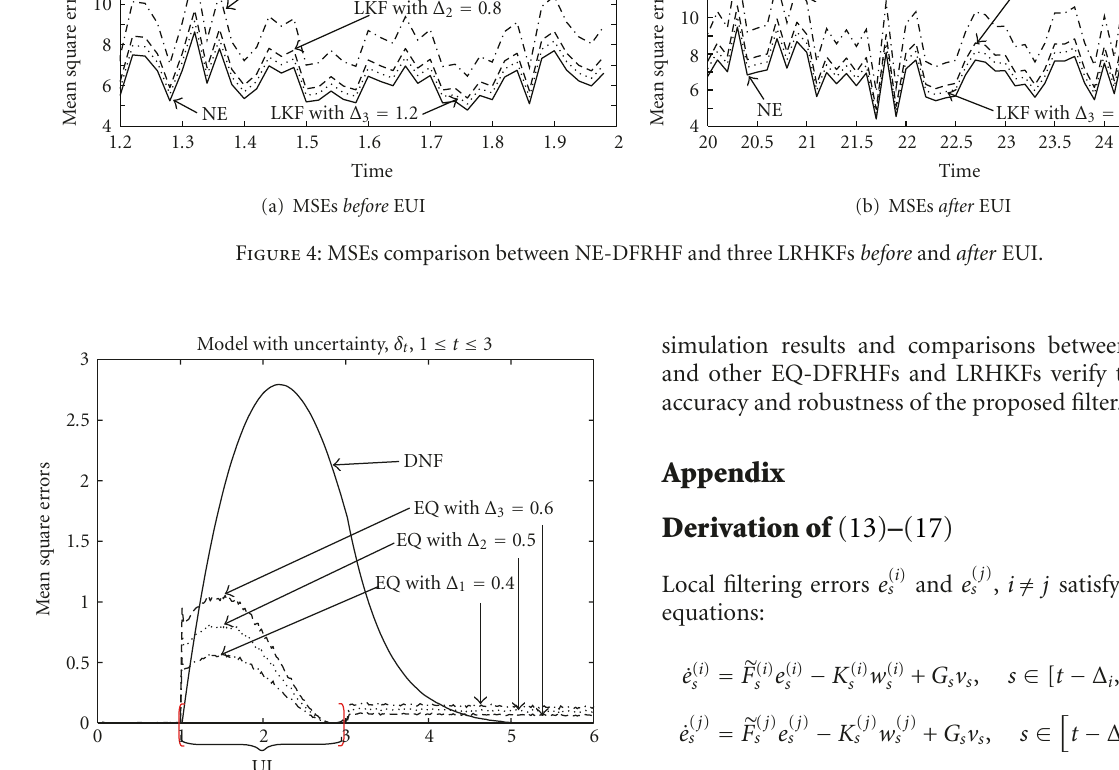
Figure 5: MSEs comparison between DNF and three